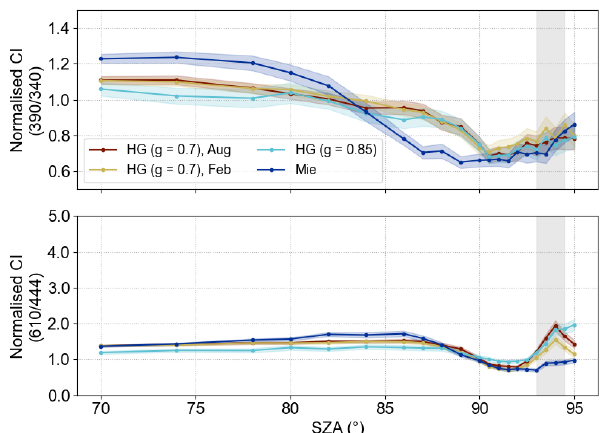
Figure B3. Simulation result (normalised CI) for different scatter- ing phase functions and atmospheric profiles. The PSC layer is de- scribed by τ PSC = 0 . 05 and h PSC = 20 to 22km. The considered phase functions are presented in Fig.